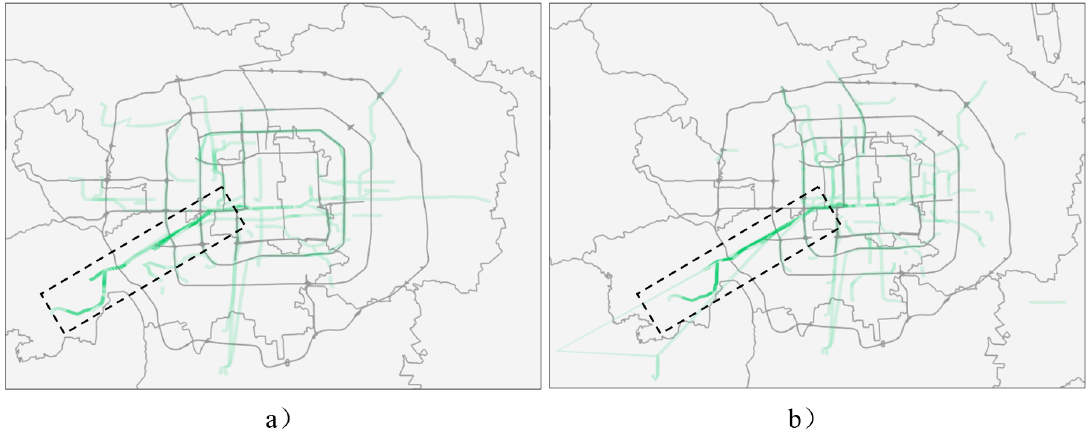
Figure 17. Passenger 2D travel trajectory view ( a ) Card number 13080401, ( b ) Card number 54278818.